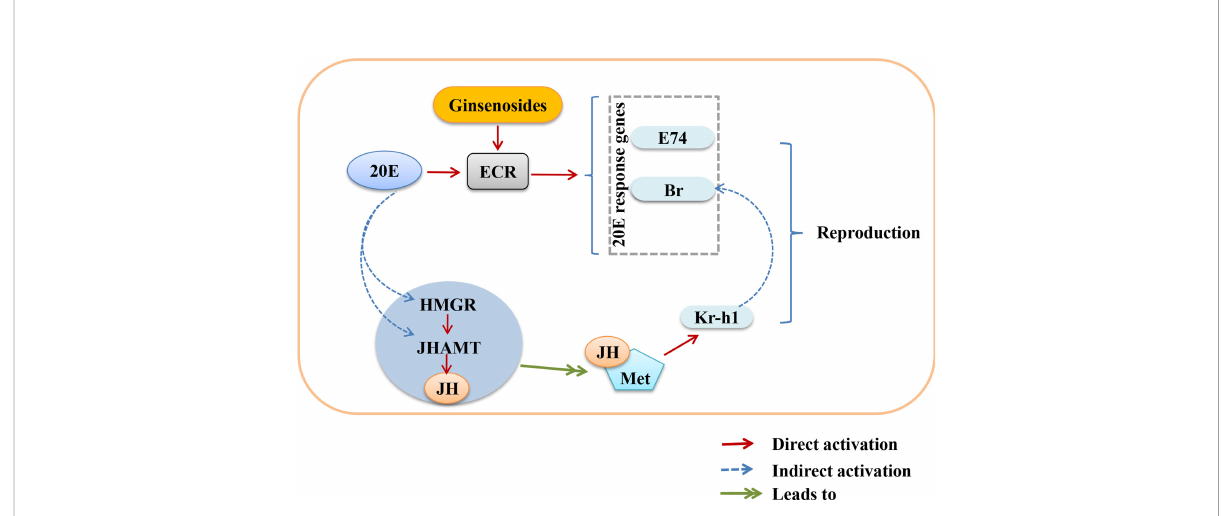
FIGURE 7 Overview showing the relationship between activation of nuclear receptor ECR by ginsenosides turns on steroid hormone signaling to improve reproductive capacity in aged female Drosophila